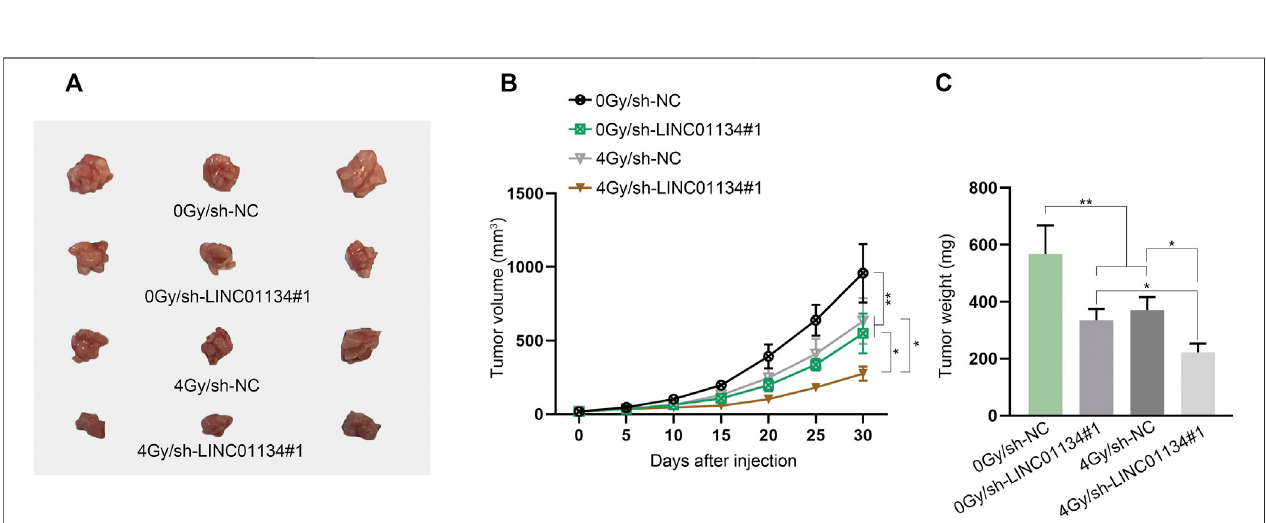
FIGURE 3 | Downregulation of LINC01134 restricts HCC tumor growth. (A) Xenograft tumors were observed and photographed after excision. (B,C) Tumor volume and weight were monitored to evaluate the tumor growth in vivo under different conditions. * p < 0.05, ** p < 0.01.